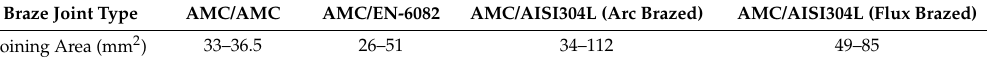
Table 5. True joining areas of dissimilar joints tested regarding shear tensile strength (Figures 7 and 8).